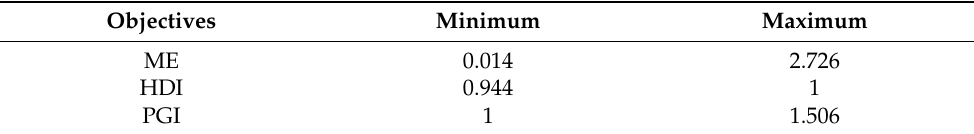
Table 5. Payoff matrix.